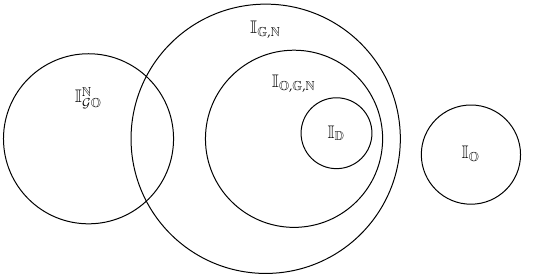
Figure 1. Intersections between families of fuzzy implication